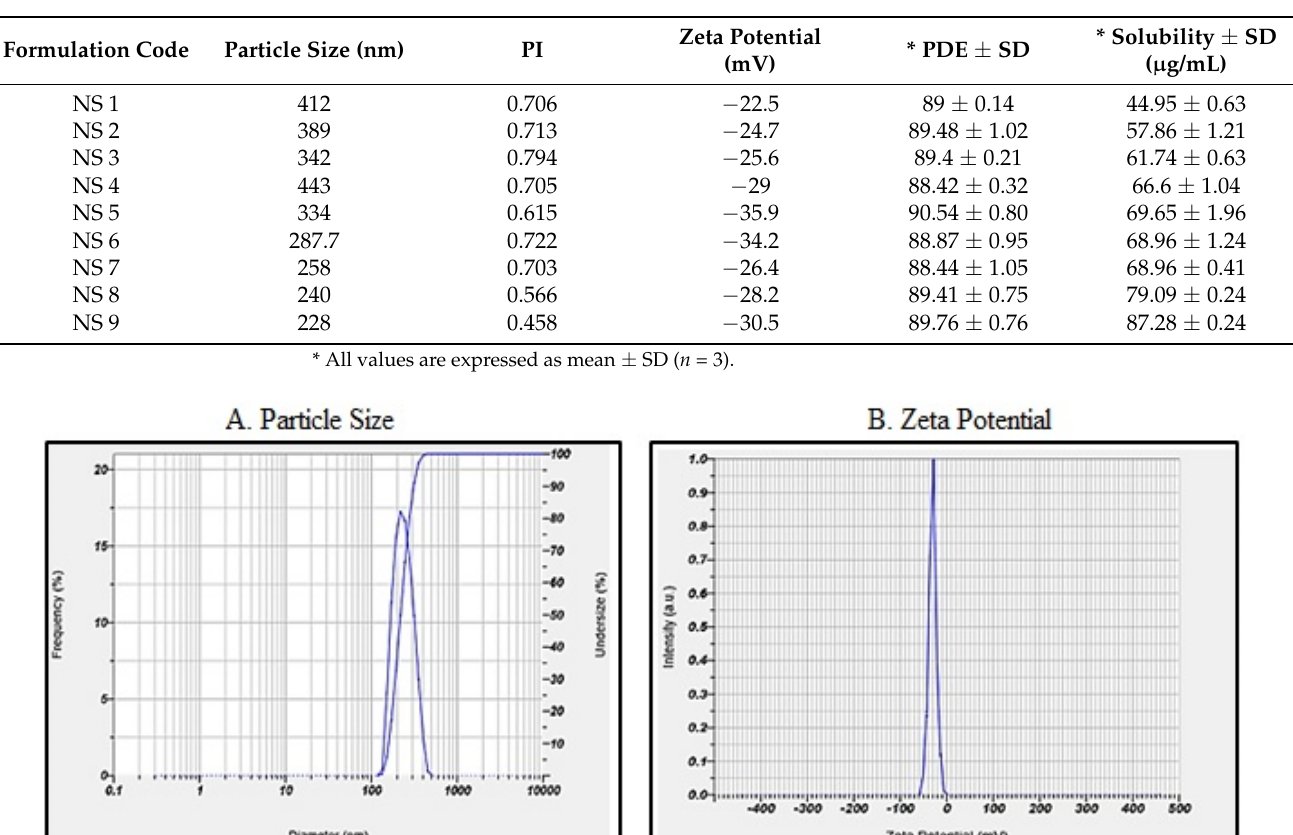
Table 7. Particle size, PI, zeta potential, PDE, and solubility of the NSs.